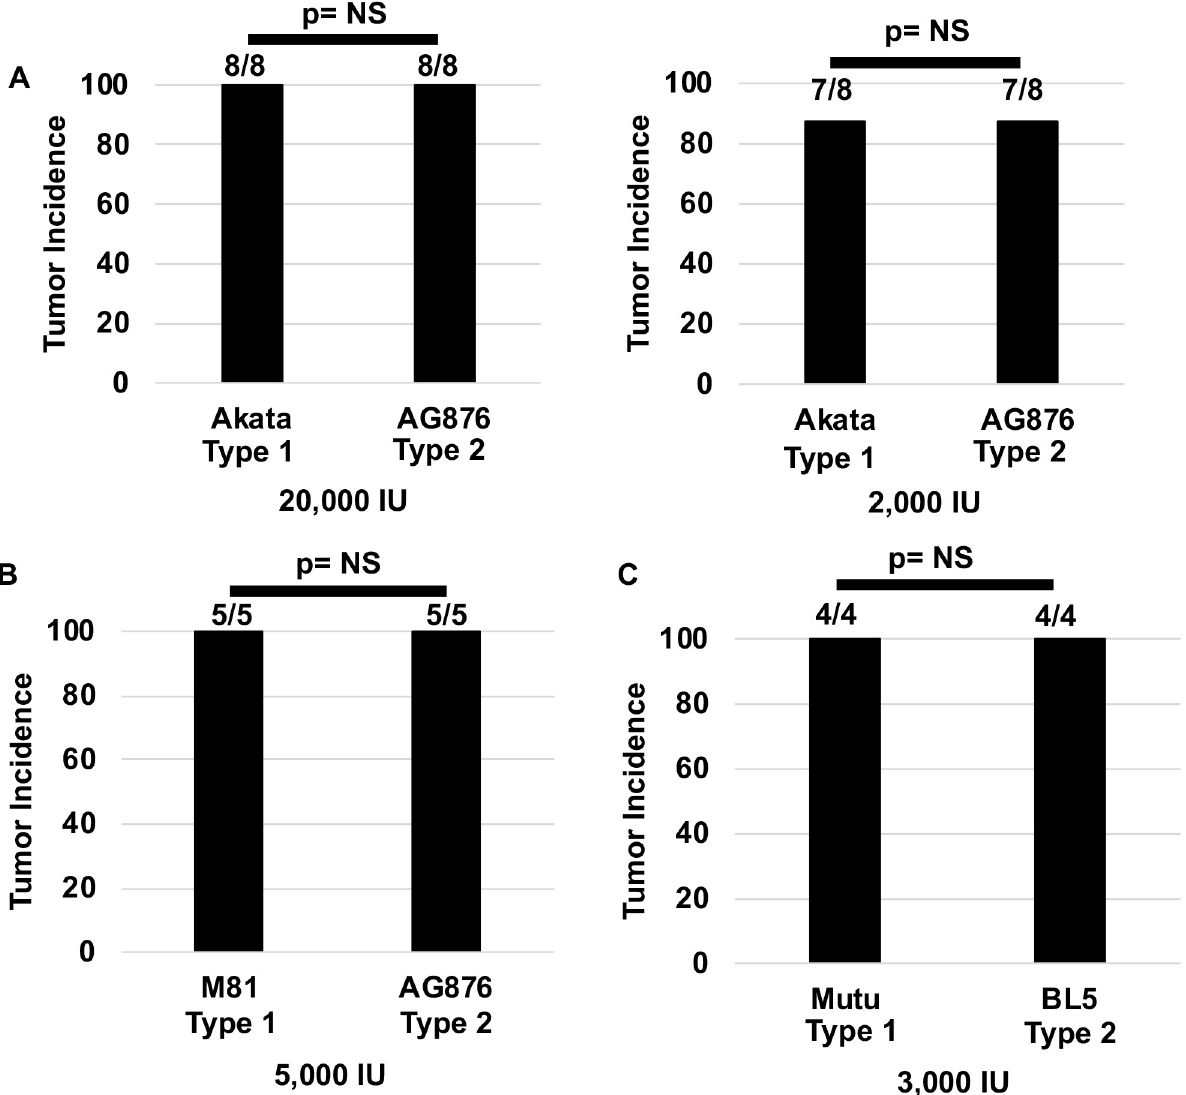
Fig 1. T2 EBV infected CBH mice develop tumors at a similar frequency as T1 EBV infected mice. A) The proportion of CBH mice that developed tumors after injection with 20,000 or 2,000 infectious units of either T1 Akata or T2 AG876 is shown. Two experiments were performed using both doses with two different donors. B) The proportion of CBH mice that developed tumors using 5,000 infectious units of T1 M81 or T2 AG876. C) The proportion of CBH mice developing tumors using 3,000 infectious units of T1 Mutu and T2 BL5 viruses. Fisher’s exact test was performed to determine if tumor frequency rates were significantly different between the different